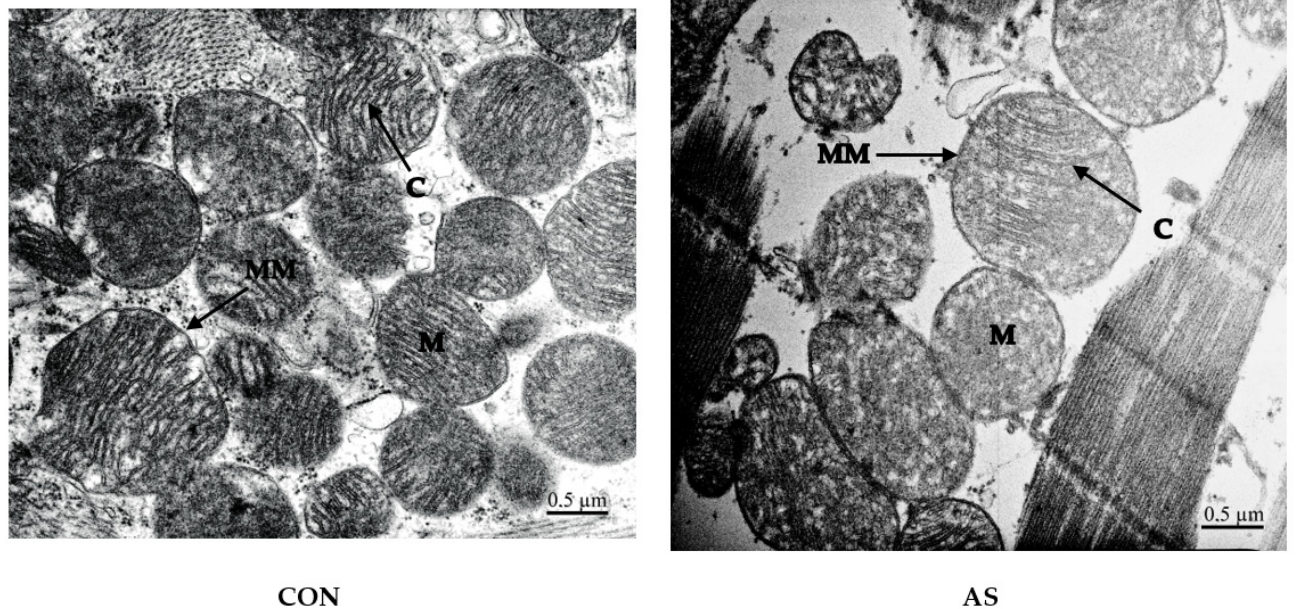
Figure 5. Representative TEM images of cardiomyocytes (×20k magnification) in CON and AS groups. No obvious changes were observed between groups in mitochondrial shapes (M), mitochondrial membrane (MM), and cristae (C).